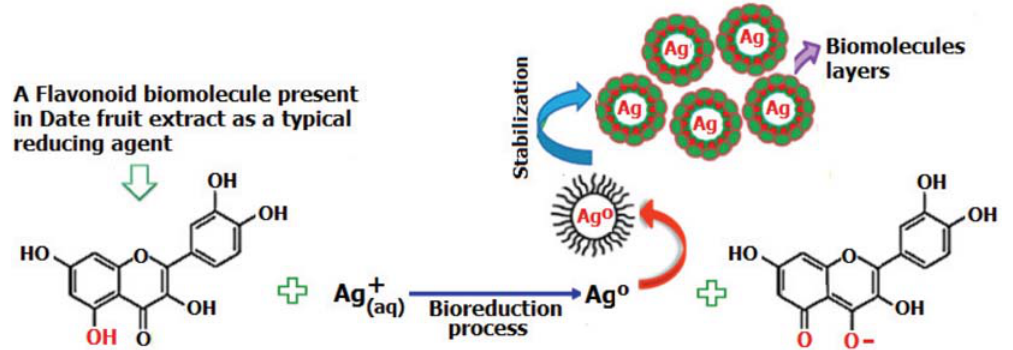
Figure 10. The plausible mechanism of the formation of Ag NPs using Date fruit extract